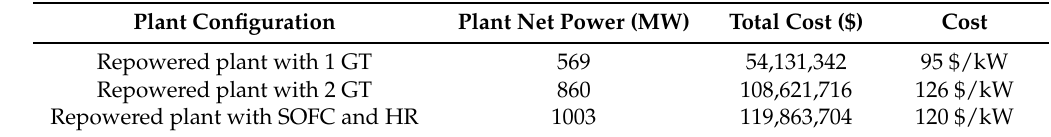
Table 8. Total cost of additional required components for